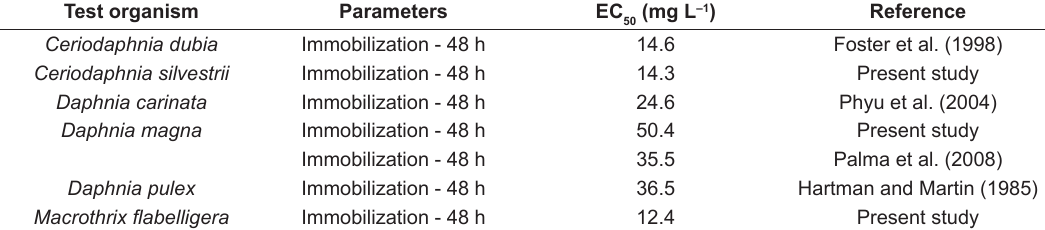
Table 2. Acute toxicity values (EC posed to atrazine.